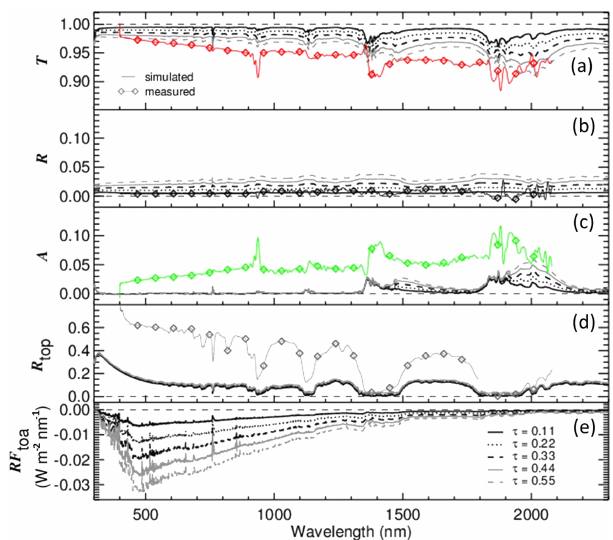
Figure 10. The lines show simulated, spectral (a) transmissivity, (b) reflectivity, and (c) absorptivity of a cirrus layer between 9 and 9.2km altitude. Panel (e) shows the radiative forcings at TOA, re- spectively. The simulations are based on a measured number size distribution assuming the mixture of shapes according Baum et al. (2005). Inserted is the measurement case (diamonds) from Fig. 7.